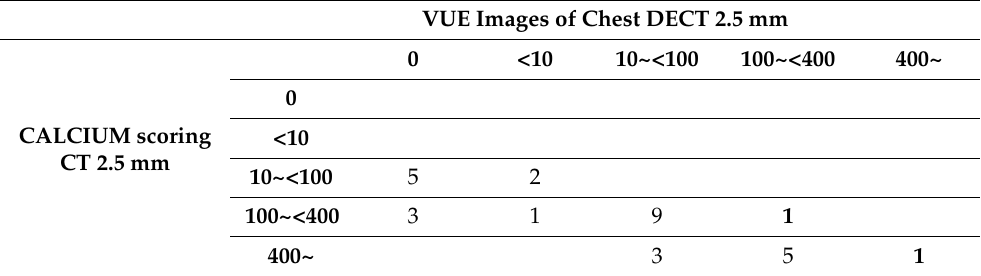
Table 5. Sectional analysis of CACS of CT and VUE images using chest DECT with 2.5 mm slice thickness.